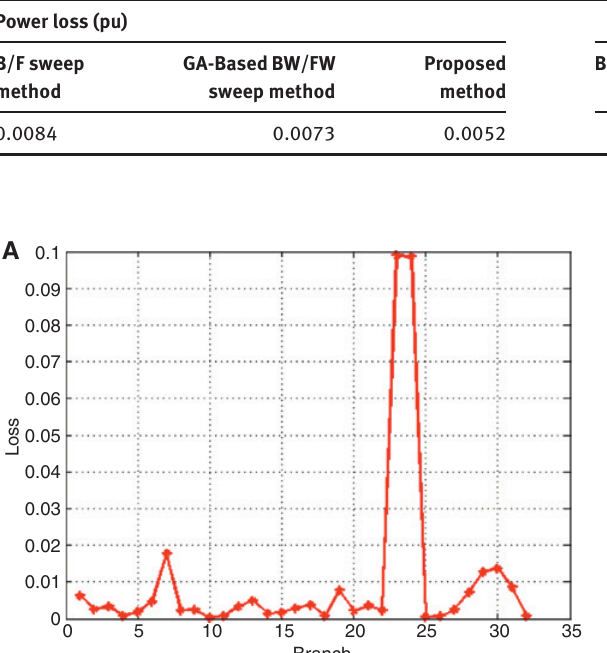
Table 4: Power Loss and Voltage Deviation